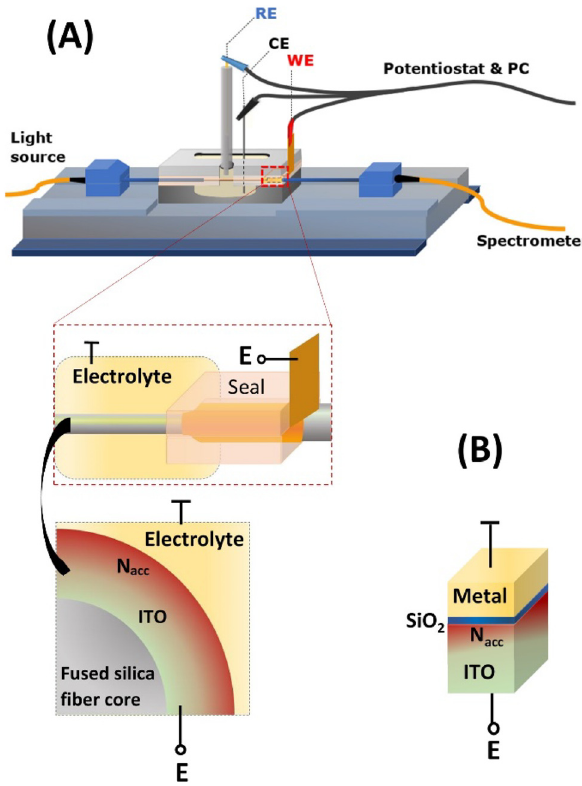
Figure 1: Schematic representation of (A) experimental setup for combined optical and EC analysis with the investigated ITO-coated optical fi ber structure and part of its cross-section. In (B) electrically equivalent model of the optical structure is schematically shown, where a monolayer of SiO 2 was introduced on ITO to represent oxidation of the fi lm